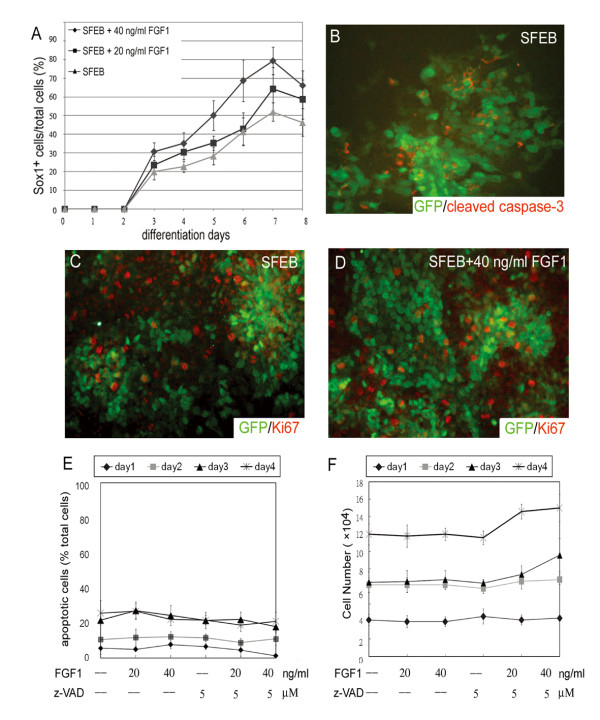
The apoptosis and the proliferation on committed neuroblast cells. (A) The induction of Sox1-GFP+ cells from 46C cells were detected by flow cytometry under the SFEB and SFEB/FGF1 condition. (B) The differentiating ES cells were labeled with cleaved caspase-3 (red), which detects the cleaved fragment of caspase-3 (17/19 kDa), in Sox1/GFP+ cells on differentiating day 4. (C, D) Proliferating GFP+ cells were marked with the nuclear staining of ki67 on day 4. (E) Total apoptotic cells, characterized with Annexin-V labeling, were estimated by flow cytometry after FGF and/or z-VAD-fmk, a membrane-permeable pan-caspase inhibitor, from day 1 to day 4. Culture media were changed every day. (F) Total cell numbers were counted in triplicate using trypan blue exclusion at indicated times.